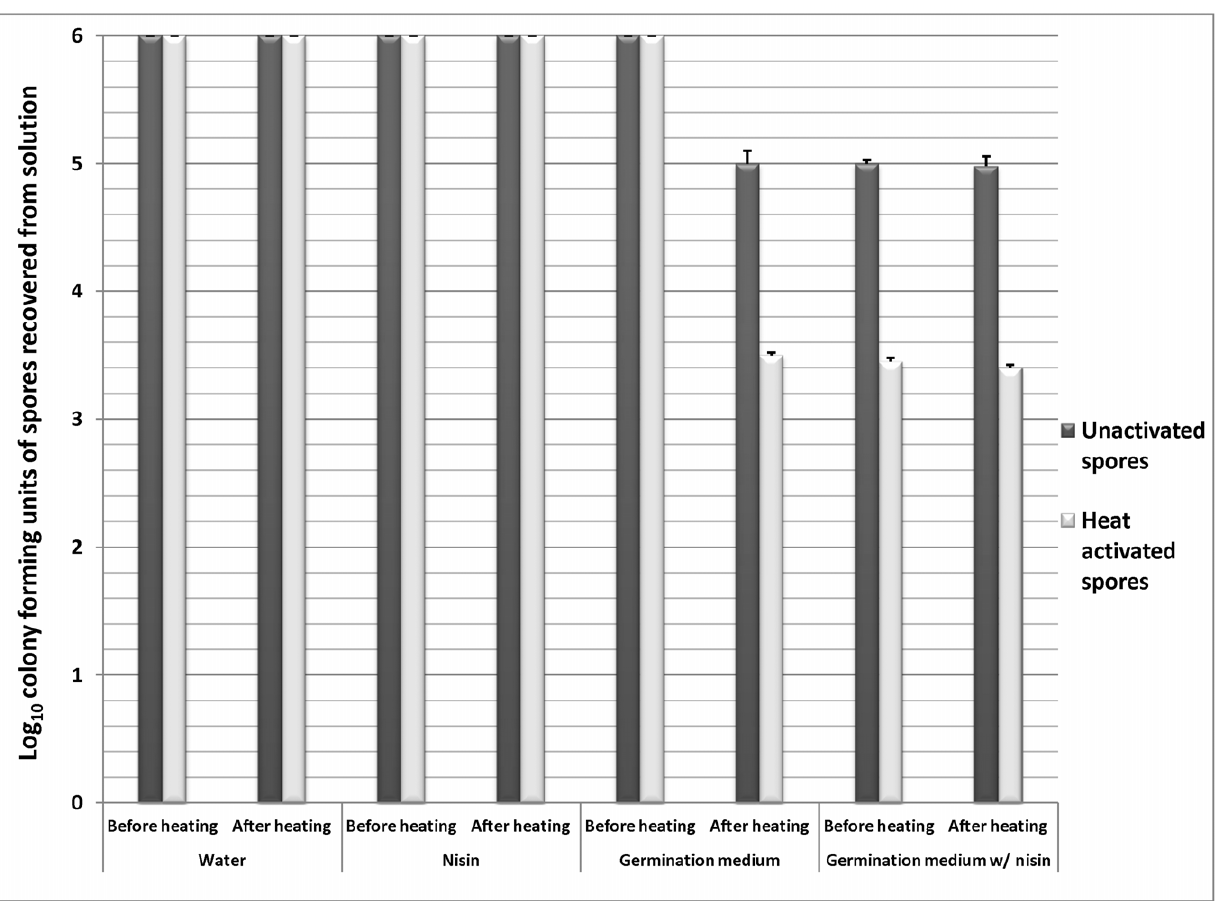
Figure 2. Inhibition of germinated C.difficile spores by nisin. The log 10 CFU of unactivated and heat activated spores that were recovered from solutions after 30 minutes of incubation under ambient conditions. Spore suspension were either plated before heating or after heating at 80 u C for 5 minutes (kills germinated but not dormant spores). Spores were confirmed as dormant or germinated by phase contrast microscopy and DPA release. The means of the data from experiments conducted in triplicate are presented. Error bars indicate standard error.